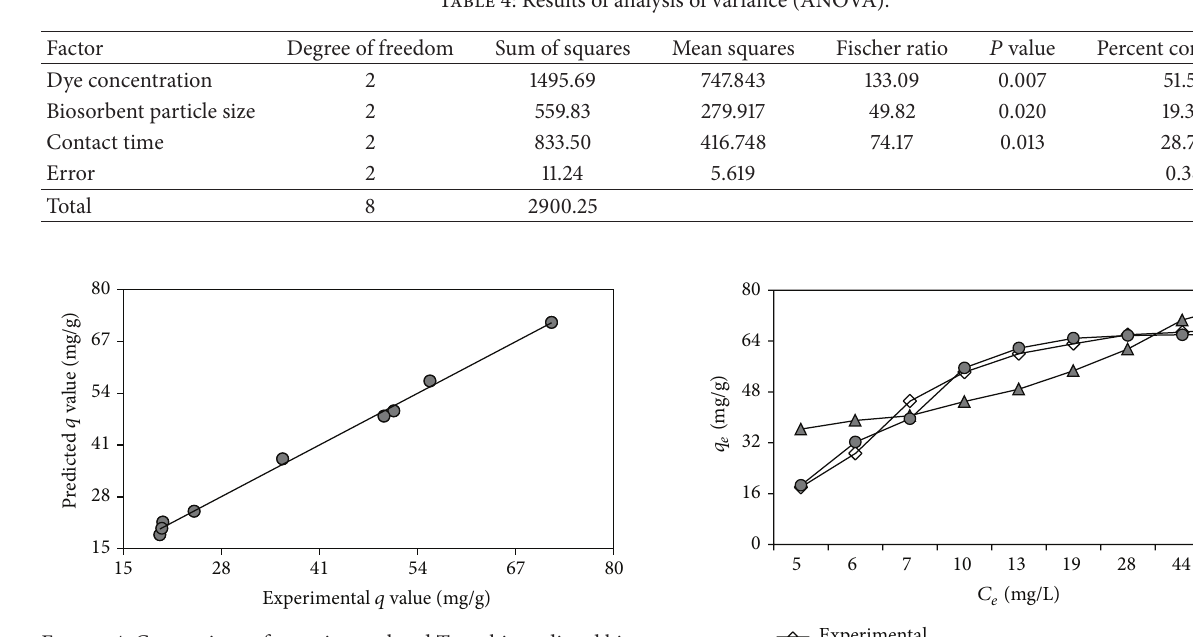
Figure 4: Comparison of experimental and Taguchi-predicted bio- sorption performance values.